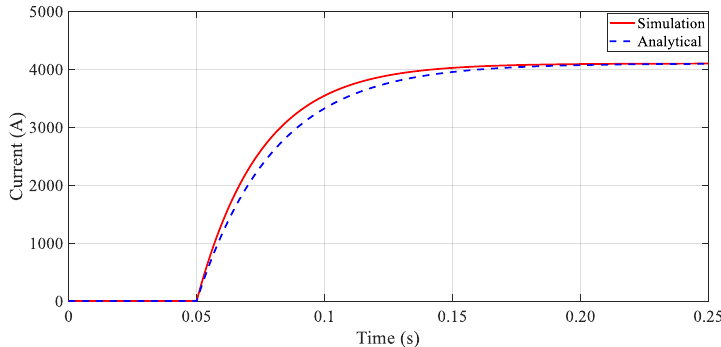
Figure 8. DC current of MMC during the fault.